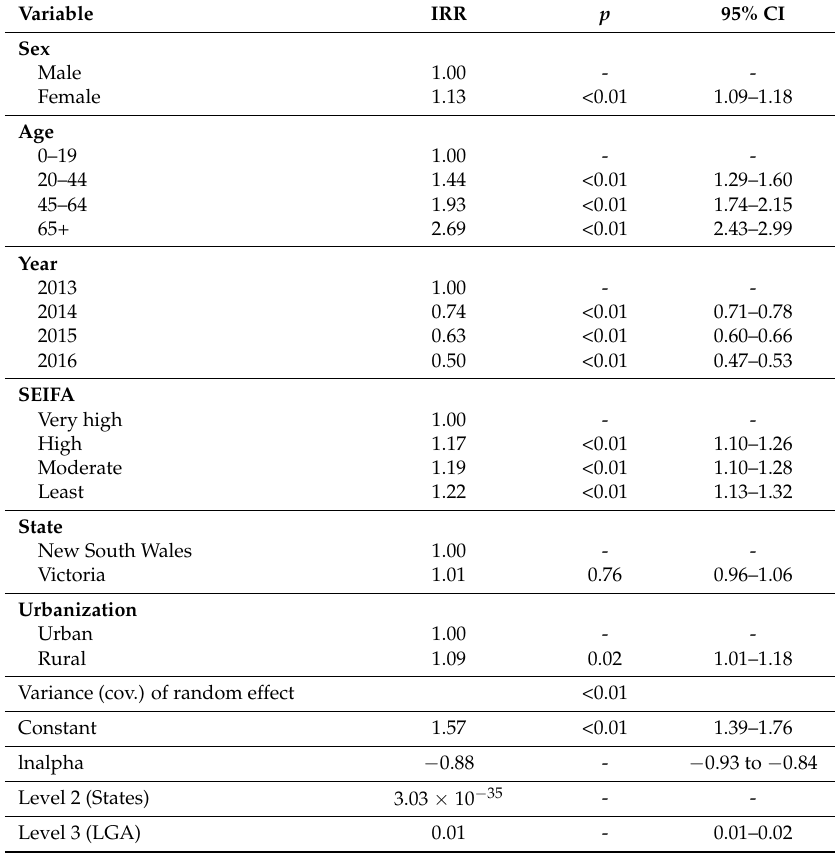
Table 1. The relationship between duration of dispensing and covariates in multilevel regression. Variable